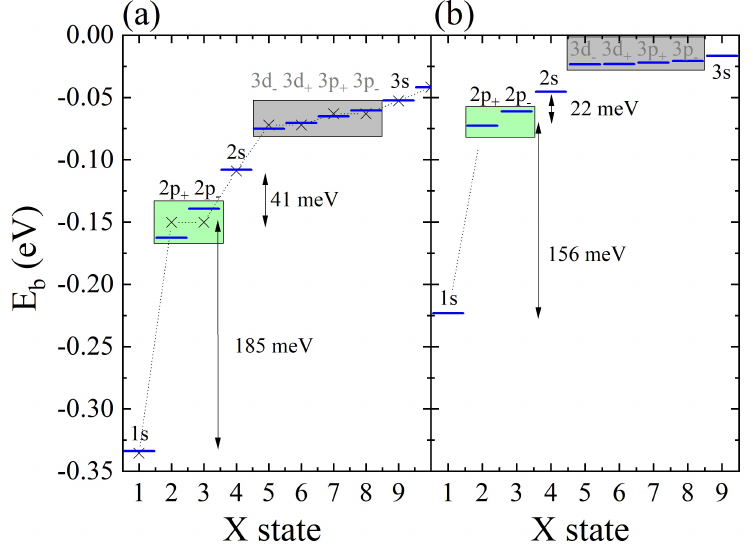
Figure 12. Exciton fine structure for the MoS 2 monolayer ( a ) on the SiO 2 substrate and ( b ) encapsu- lated with hBN, in a full TB model with complex electron–hole interaction included. Results restricted to the first three shells. The topological splitting of 2 p , 3 p , and 3 d states in the excitonic spectrum of the MoS 2 layer is